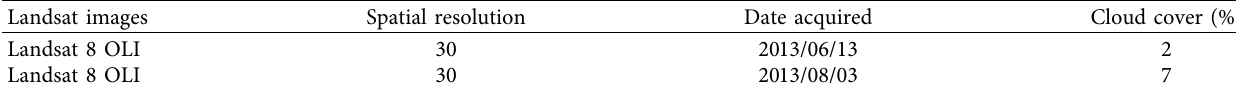
Table 1: Landsat images